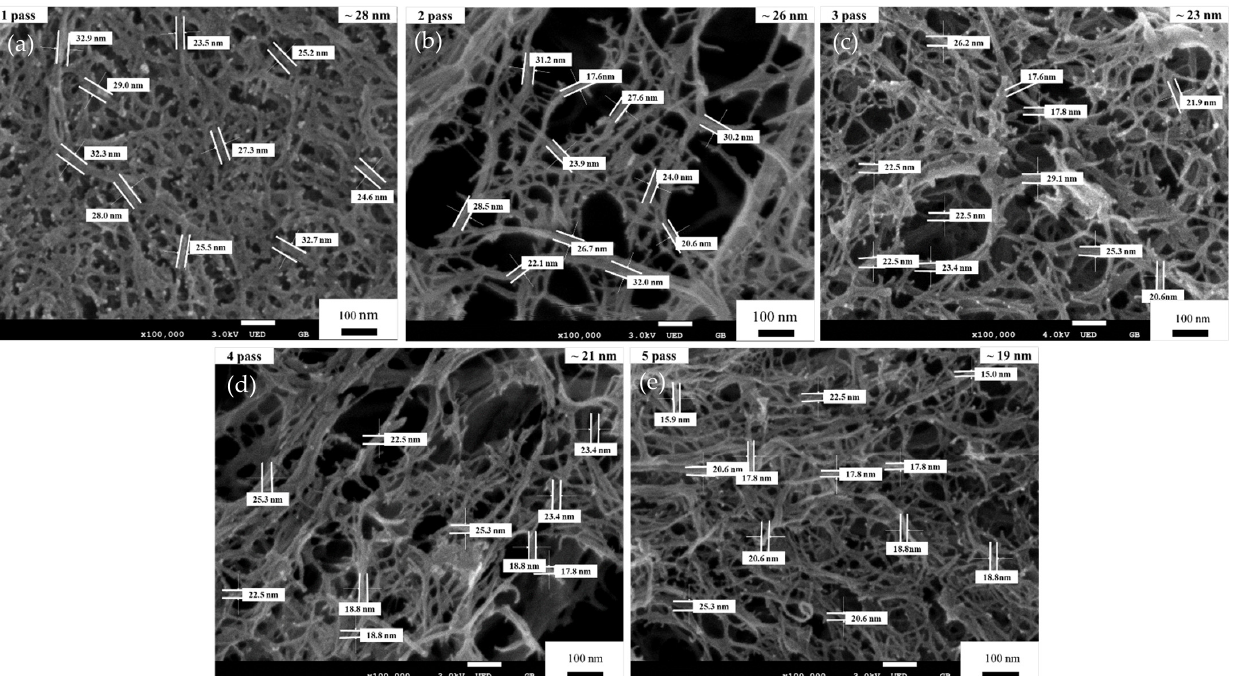
Figure 13. FE-SEM micrographs (×100,000) of CNFs after disc grinding the dry cellulose powder for ( a ) one pass, ( b ) two passes, ( c ) three passes, ( d ) four passes, and ( e ) five passes.